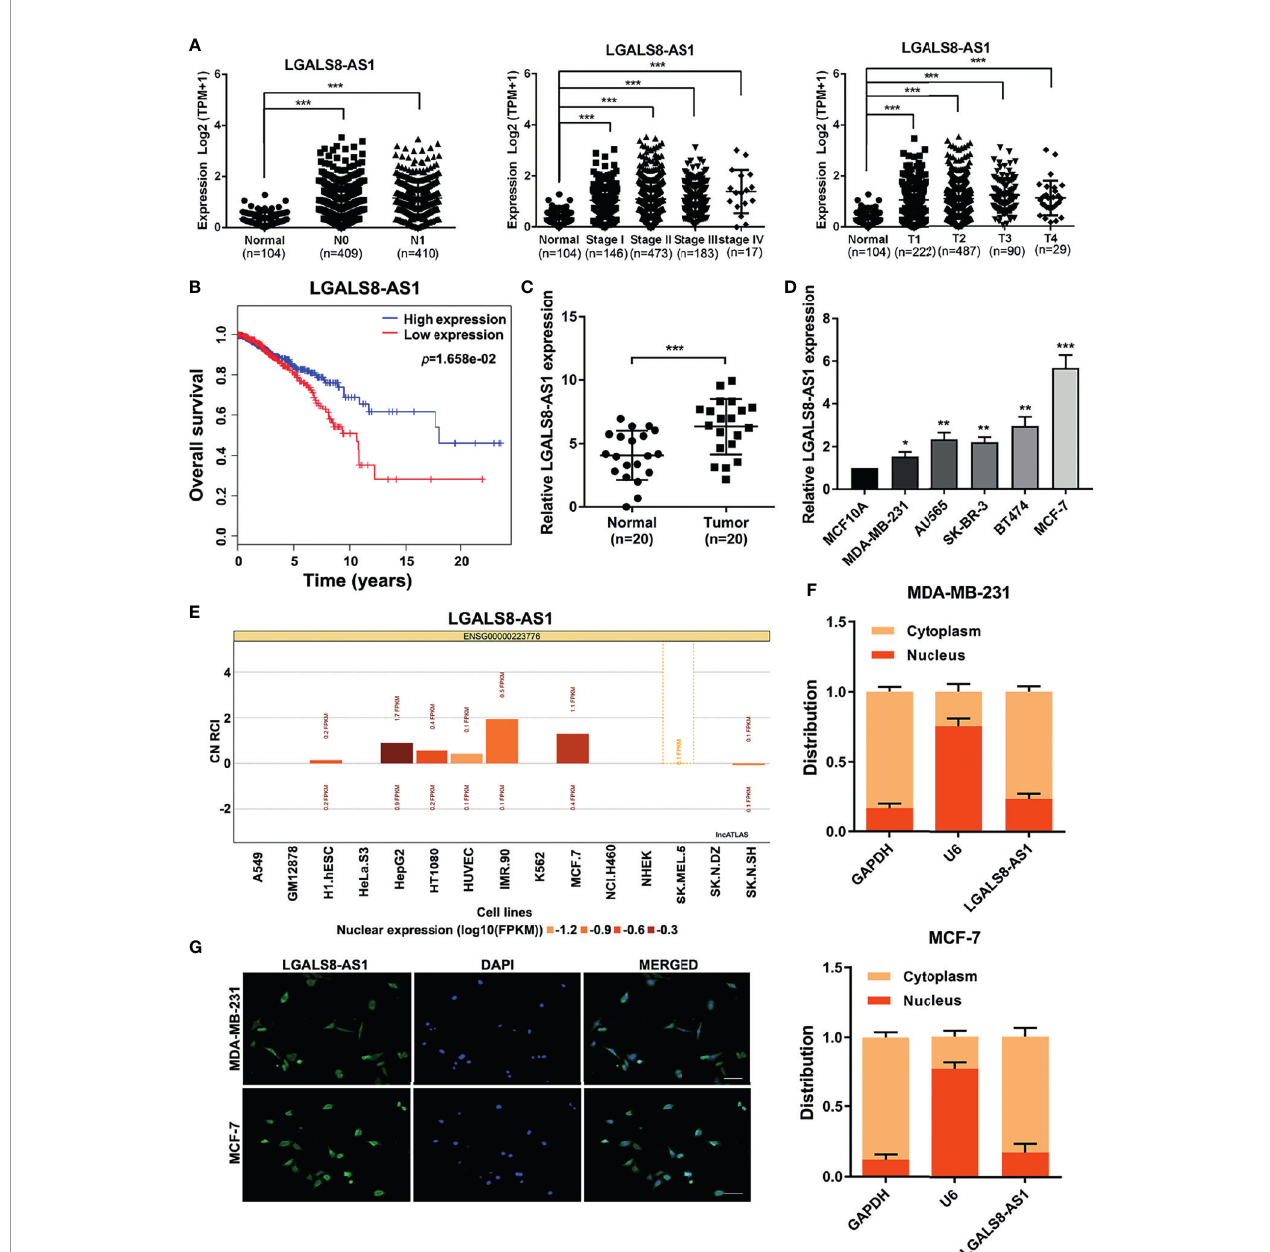
FIGURE 1 | The lncRNA LGALS8-AS1 is speci fi cally upregulated in breast cancer tissues and cell lines. (A) Analysis of LGALS8-AS1 expression among different clinical stages performed in the breast cancer gene (BRCA) dataset of The Cancer Genome Atlas (TCGA). (B) Kaplan – Meier plotter for LGALS8-AS1 expression in TCGA BRCA dataset. (C) Expression of LGALS8-AS1 detected in breast cancer tissues and corresponding paracancerous tissues using real-time quantitative PCR (RT-qPCR). (D) Expression of LGALS8-AS1 detected in different breast cancer cell lines using RT-qPCR. (E) Subcellular localization of LGALS8-AS1 in different cells queried in the lncATLAS database. (F) LGALS8-AS1 expression in the nucleus and cytoplasm of MDA-MB-231 and MCF-7 cells detected by RT-qPCR. (G) RNA fl uorescence in situ hybridization (RNA-FISH) assay performed to detect the subcellular localization of LGALS8-AS1 in breast cancer cells. LGALS8-AS1 is stained in green and nuclei are stained in blue (DAPI). * p < 0.05, ** p < 0.01, *** p <